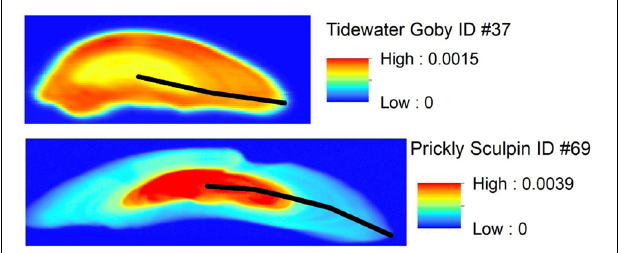
FIGURE 2 | Spatial distribution of Sr concentration (ppm) in example otoliths from a Tidewater Goby (frontal section) and Prickly Sculpin (transverse section). Lines on each otolith represent the growth plane where Sr:Ca chronologies were obtained. Note that images are not on the same scale: